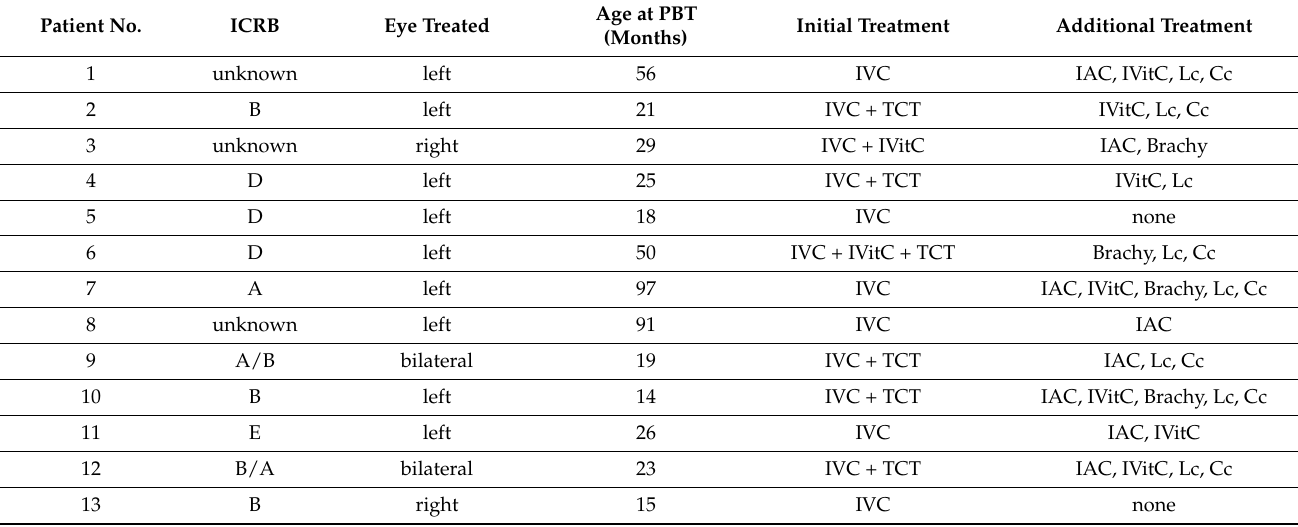
Table 1. Initial findings, demographic data and treatment prior to proton beam therapy (PBT).